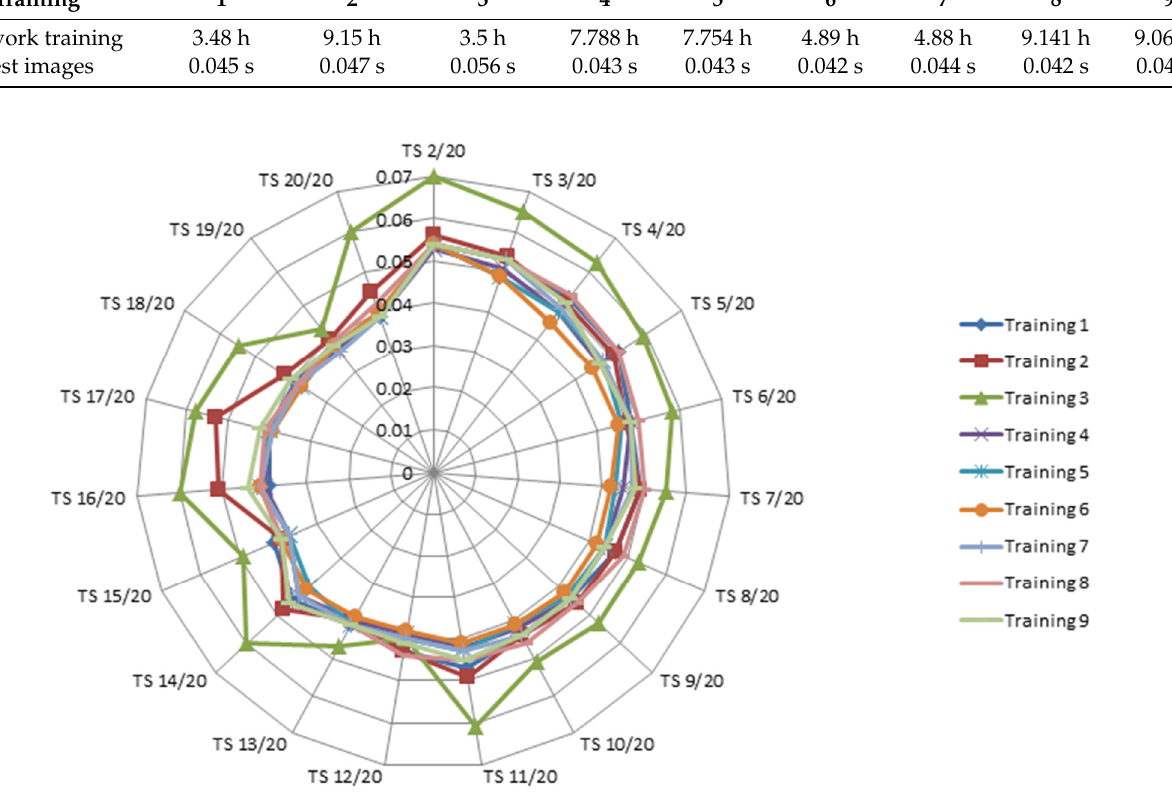
Figure 10. Comparative representation of detection time, in seconds, in 20 test images for all trainings.